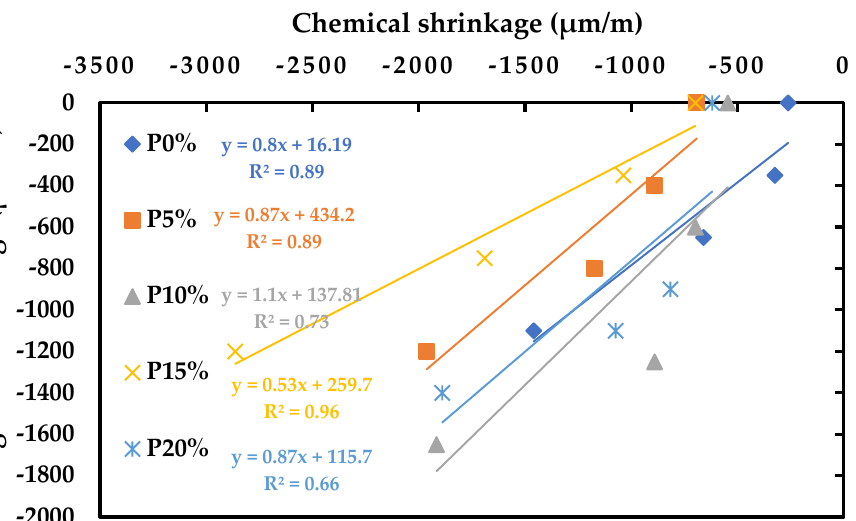
Figure 15. Correlation between chemical shrinkage and autogenous shrinkage for pastes.